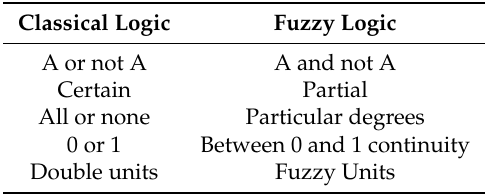
Table 1. Main differences of classical and fuzzy